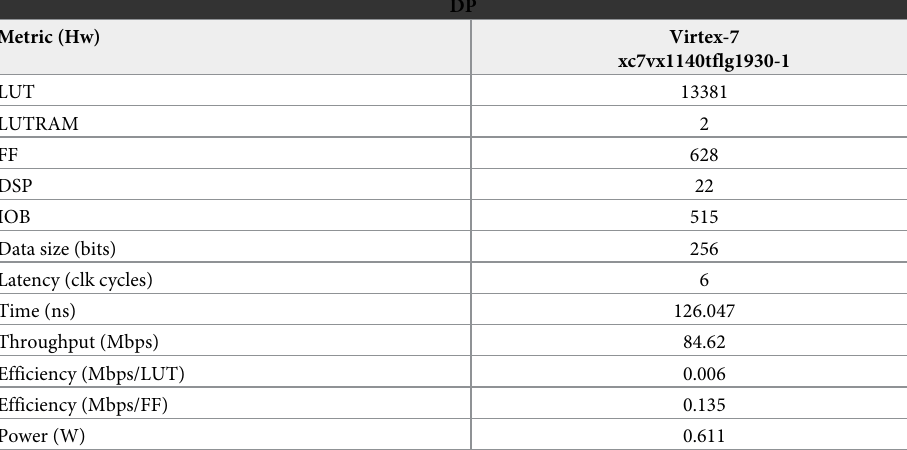
Table 7. Implementation results for the DP-based hardware architecture.